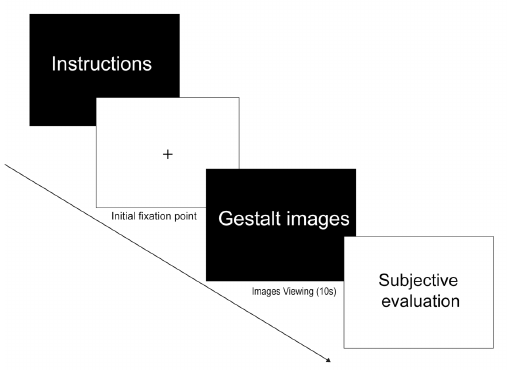
Figure 5. Flow chart of experimental procedure